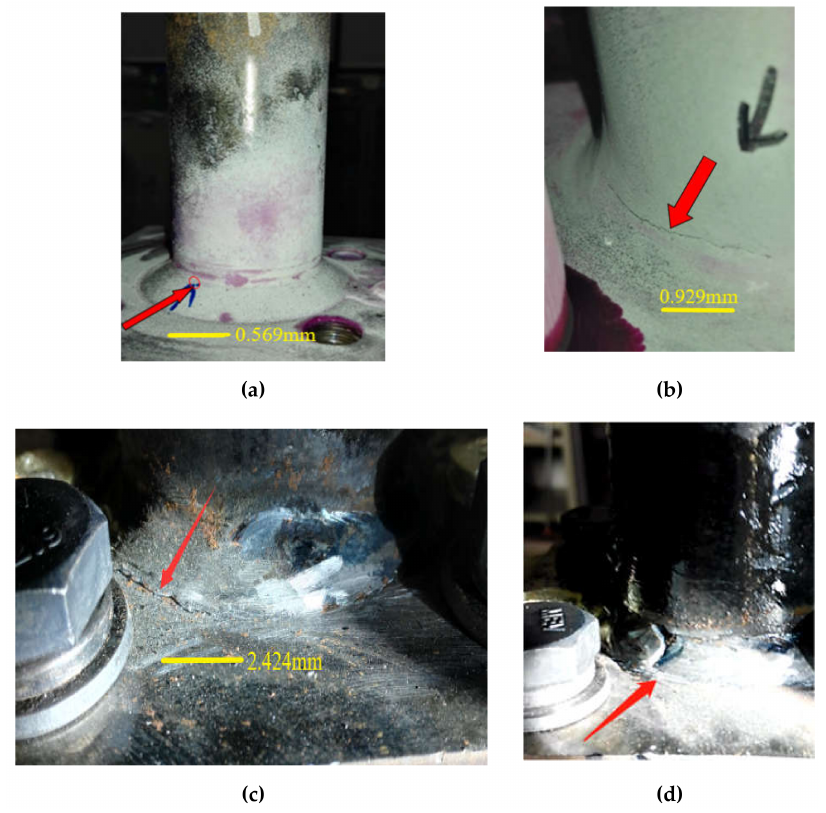
Figure 8. Cracks of T-type tube-plate joint ( a ) observed crack of 0.569 mm length ( b ) observed crack of 0.929 mm length ( c ) observed crack of 2.424 mm length ( d ) large crack initiated at edges of the base